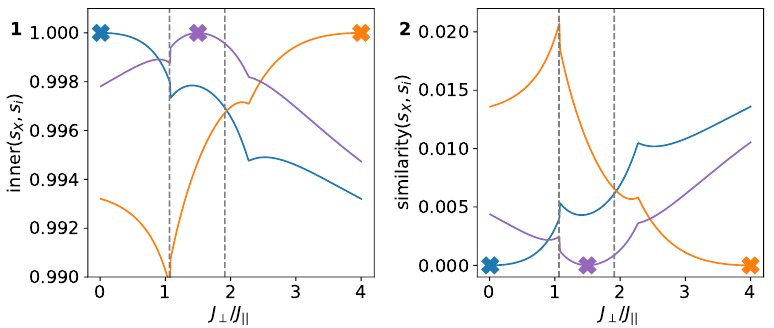
Figure 4: Detecting the phase boundaries with purely geometric data driven methods / J = 0.3. 1) Inner product between the singular values S at J || x eter space and a fixed point (indicated by the X). 2) Geometric similarity measure equivalent of the loss for the autoencoder eq.